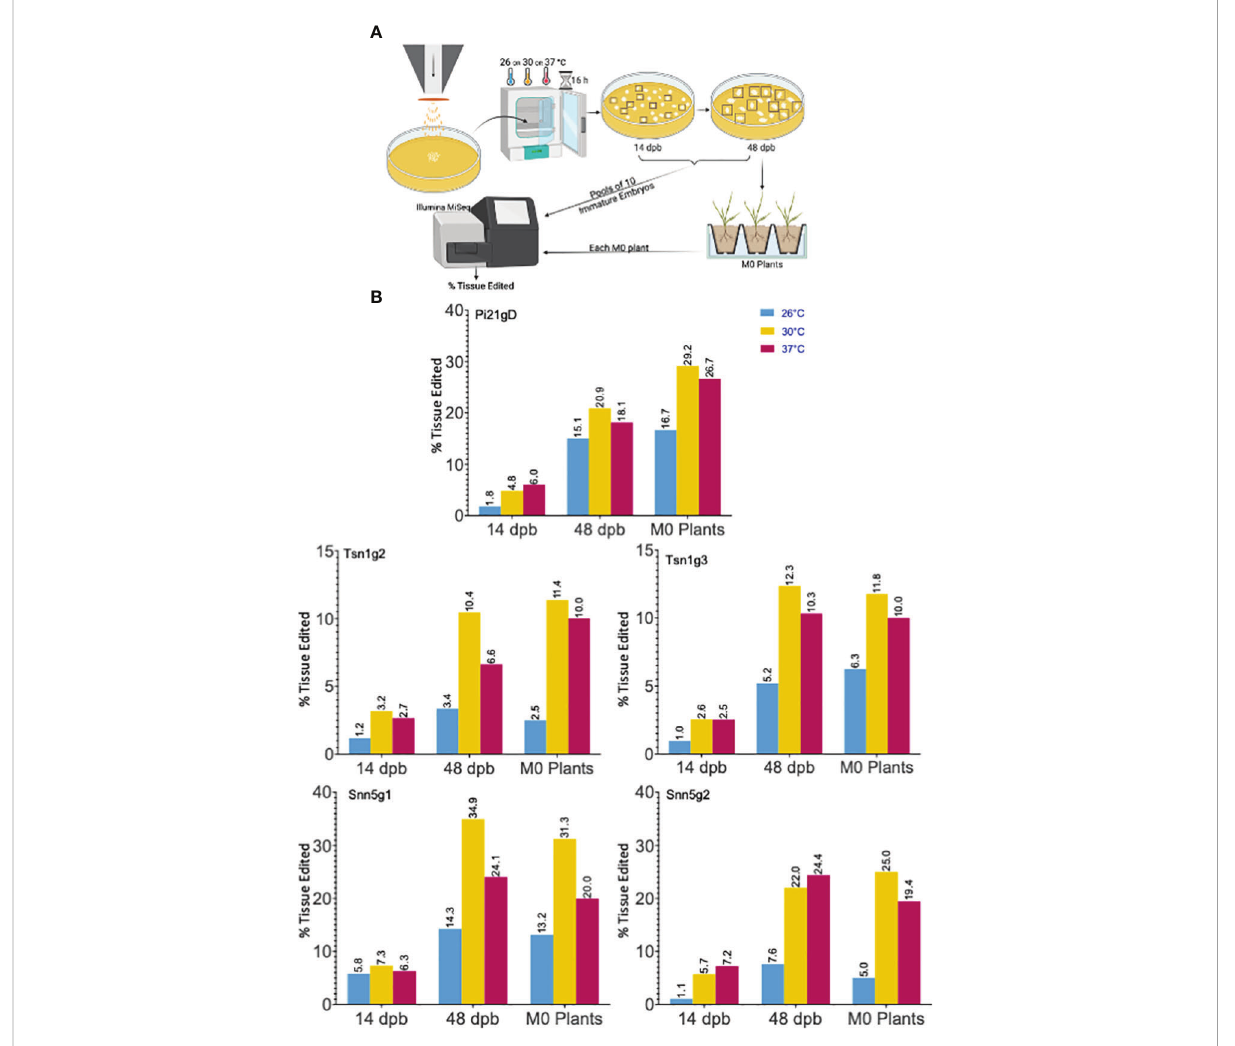
FIGURE 2 Cas9-RNP particle bombardment and temperature treatment of wheat immature embryos (IEs). (A) A schematic of the particle bombardment and editing ef fi ciency assay pipeline. (B) Targeted editing ef fi ciency of gRNA-Cas9 ribonucleoproteins with different temperature treatments in IEs across time points. Five gRNAs, Pi21gD, Tsn1g2, Tsn1g3, Snn5g1, and Snn5g2 were bombarded independently into IEs. Tissue pools at 14 dpb and 48 dpb consisted of 10 randomly chosen initially bombarded IEs. Editing ef fi ciency for M 0 plants is based on aggregate data from